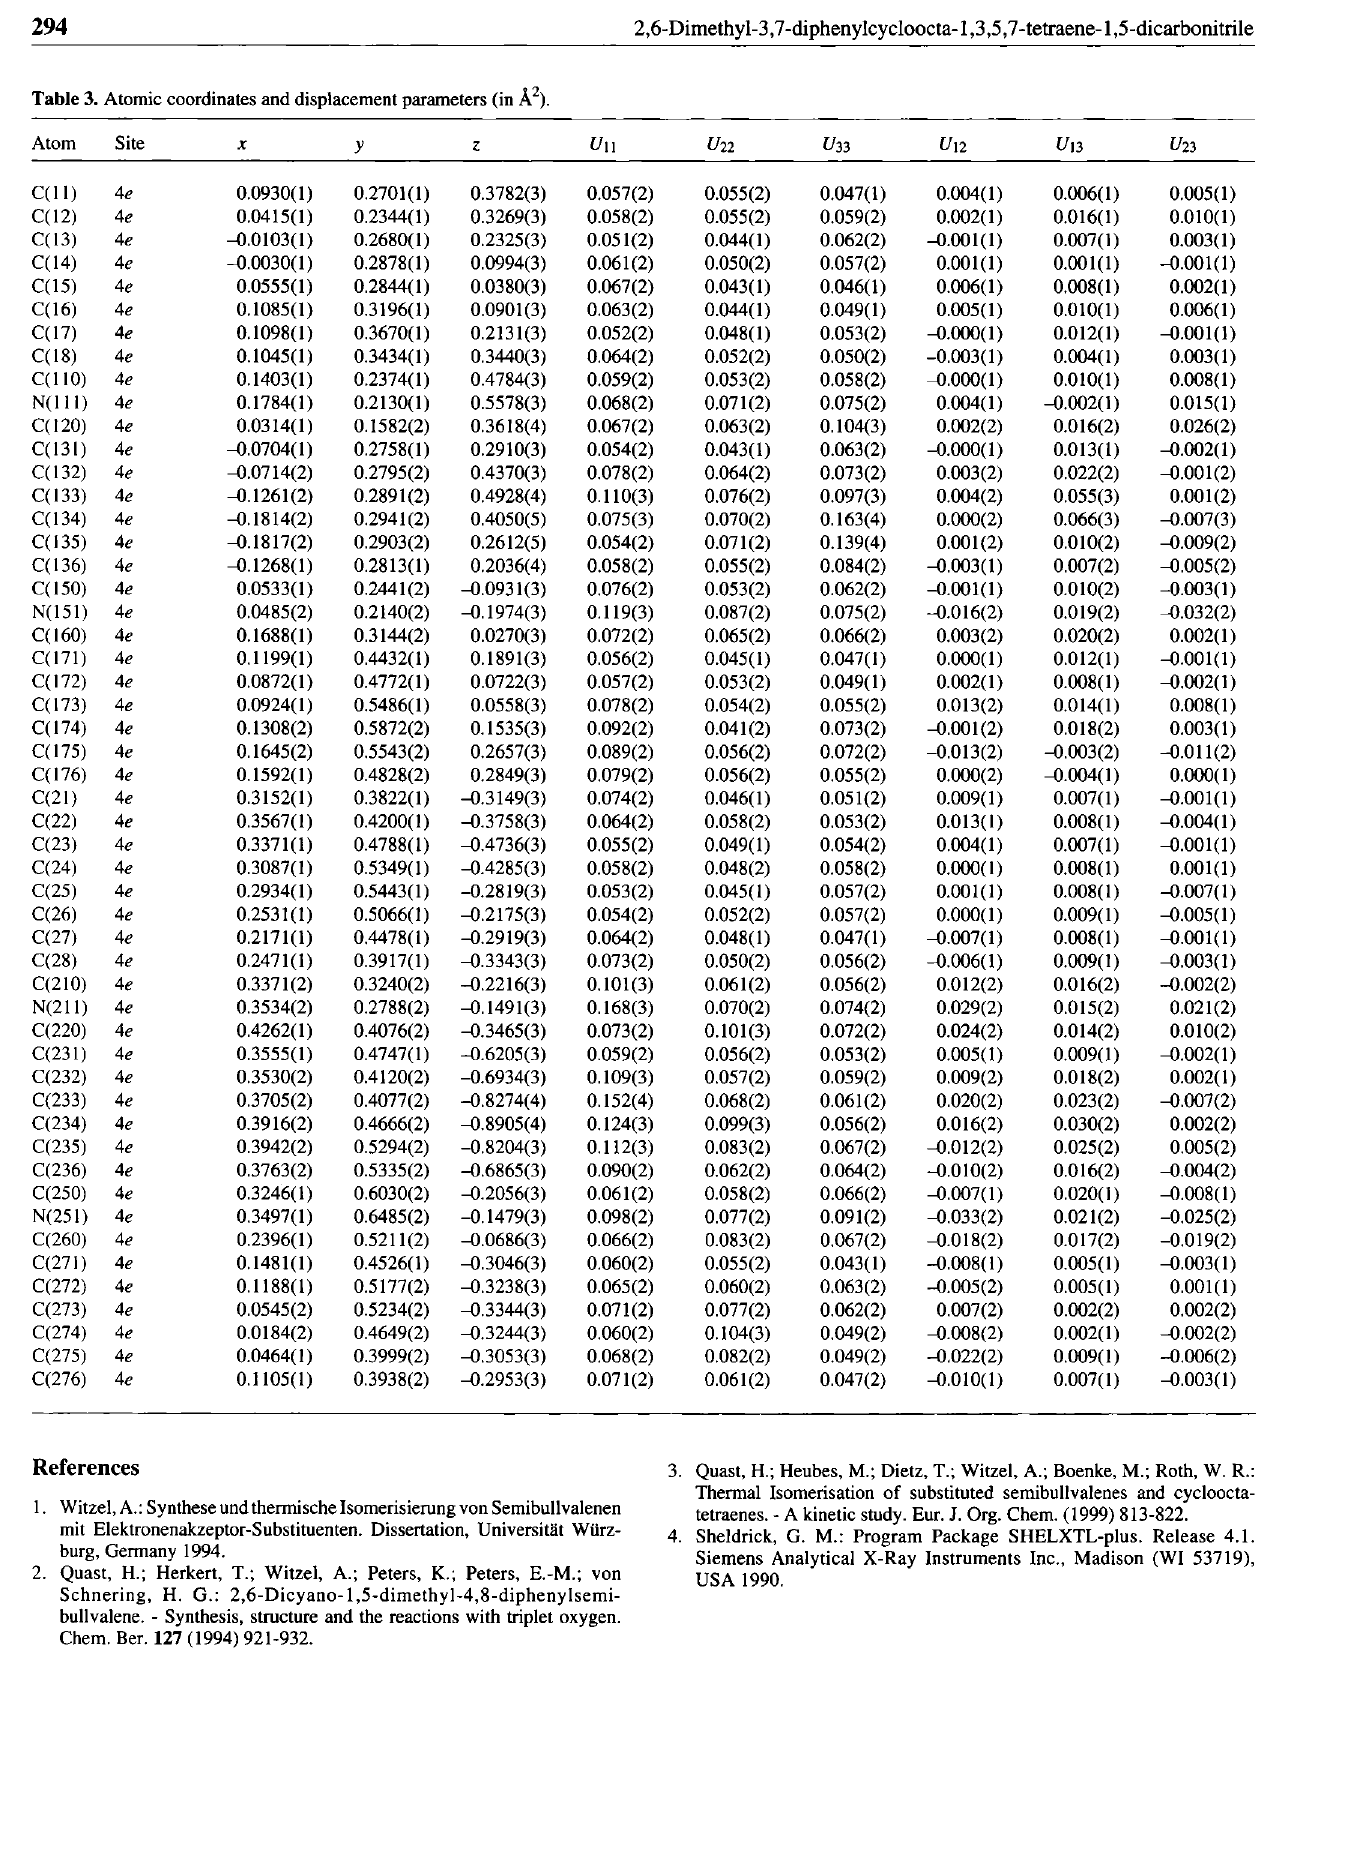
Table 3. Atomic coordinates and displacement parameters (in Ä 2